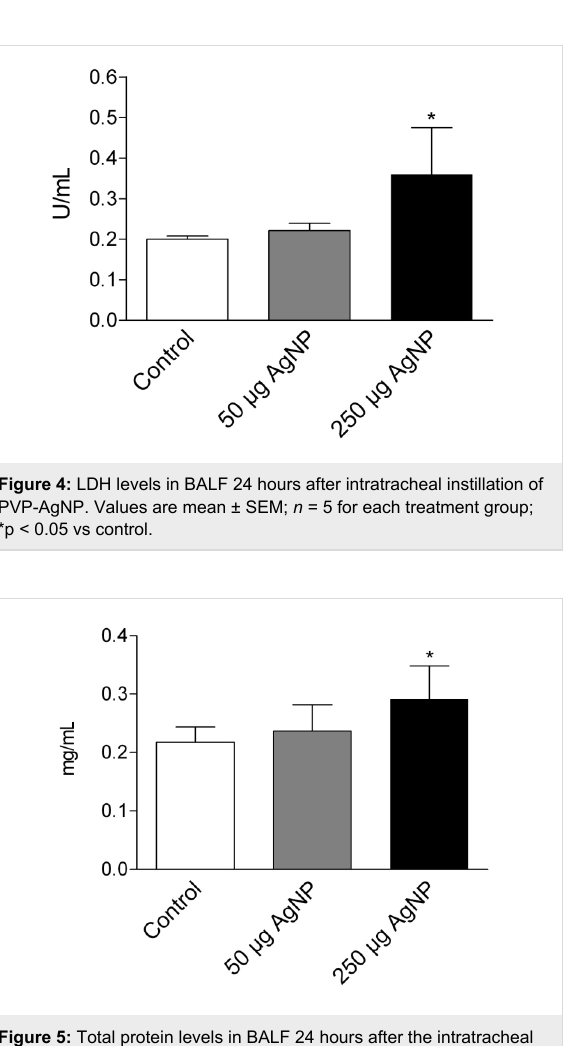
Figure 5: Total protein levels in BALF 24 hours after the intratracheal instillation of PVP-AgNP. Values are mean ± SEM; n = 5 for each treat- ment group; *p < 0.05 vs